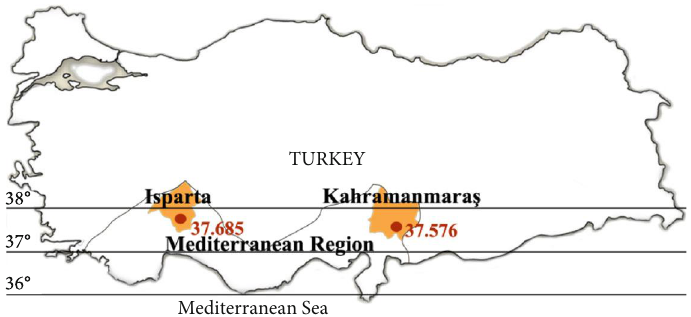
Figure 2: Geographical positions of target provinces and measurement